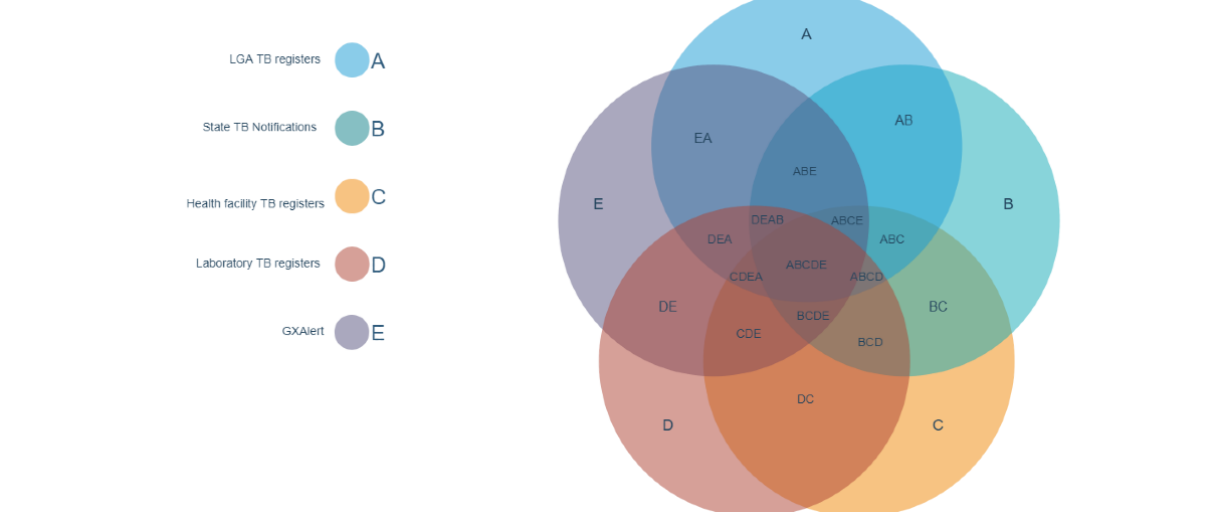
Figure 6. Comparison of TB data sets to discern the level of misreporting of TB notifications. LGA: local government area; TB: